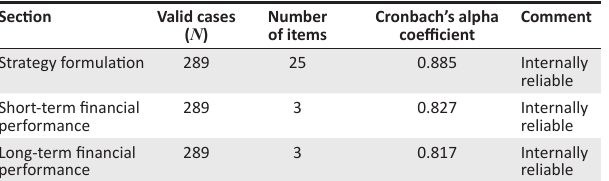
TABLE 2: Cronbach’s alpha for the strategy formulation and perceived financial performance scale.